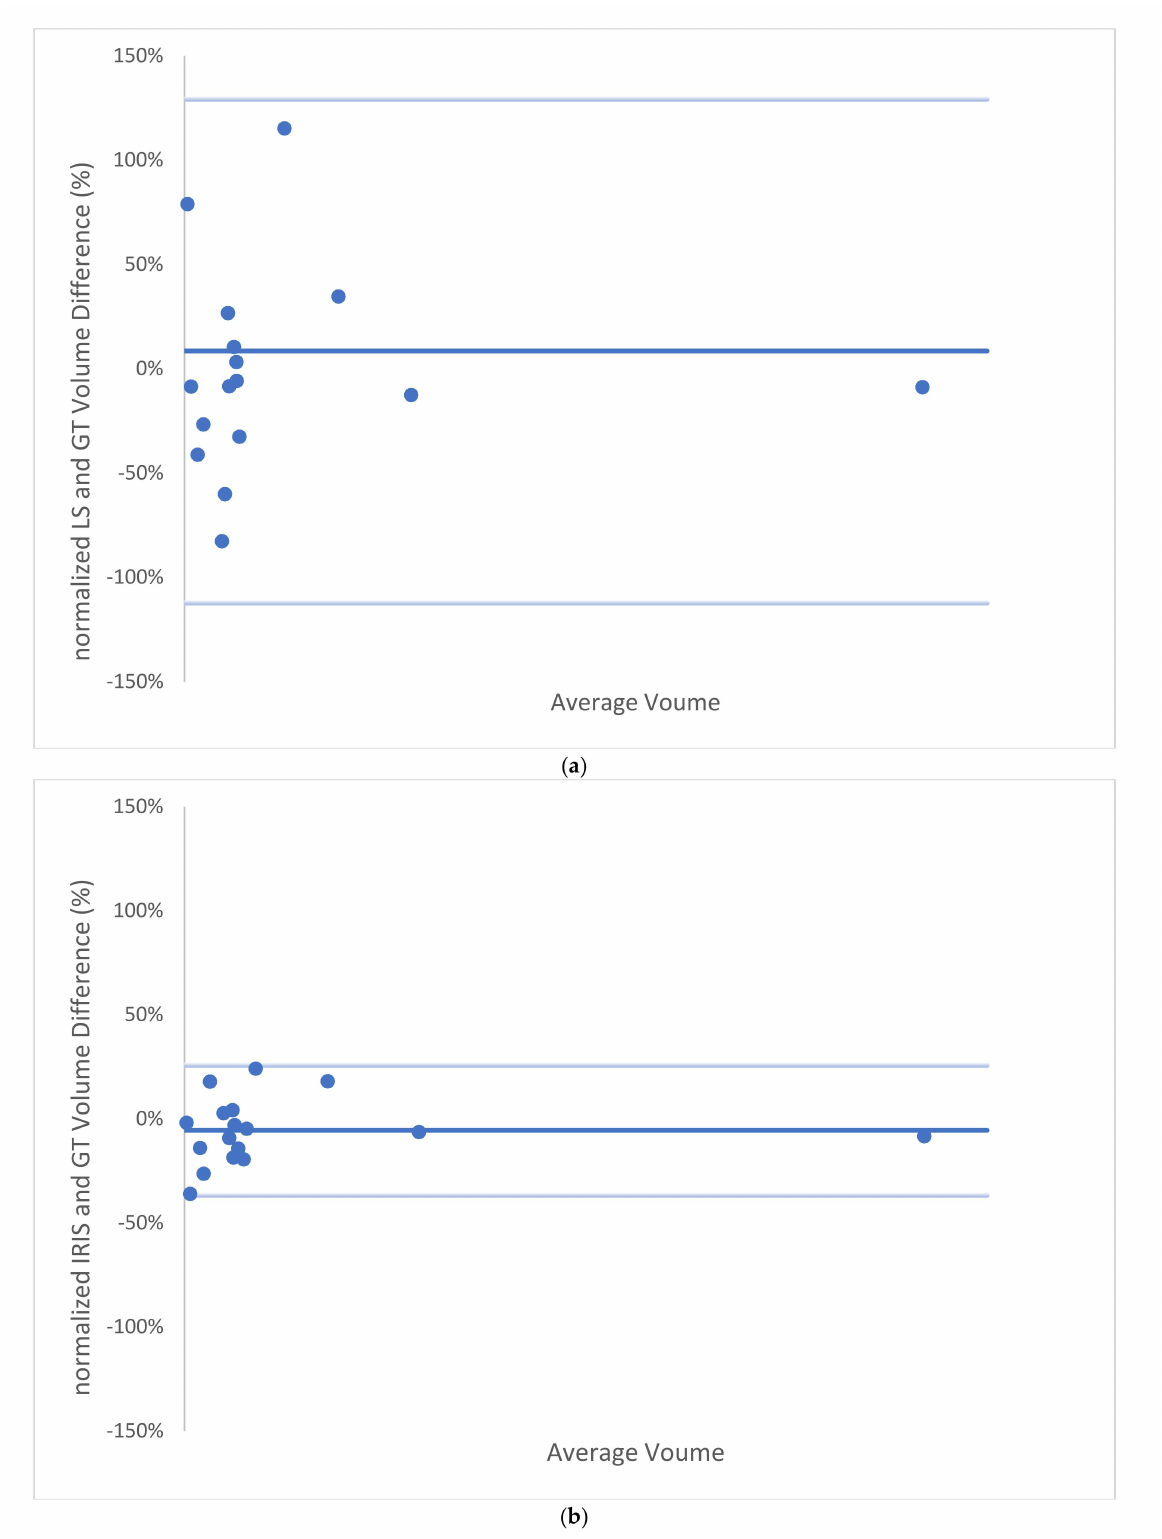
Figure 3. Bland–Altman plots for ( a ) LS and ( b ) IRIS for cyst volume measurements. LS had a bias of 8.53%, STD of 61.61%, lower limit of agreement (LLA) of − 112%, and upper limit of agreement (ULA) of 129%. ( a ). IRIS had a bias of − 5.49%, STD of 15.94%, LLA of − 37%, and ULA of 26%. GT = ground truth segmentation, LS = automatic level set segmentation, IRIS = intelligent rapid interactive segmentation, and STD = standard